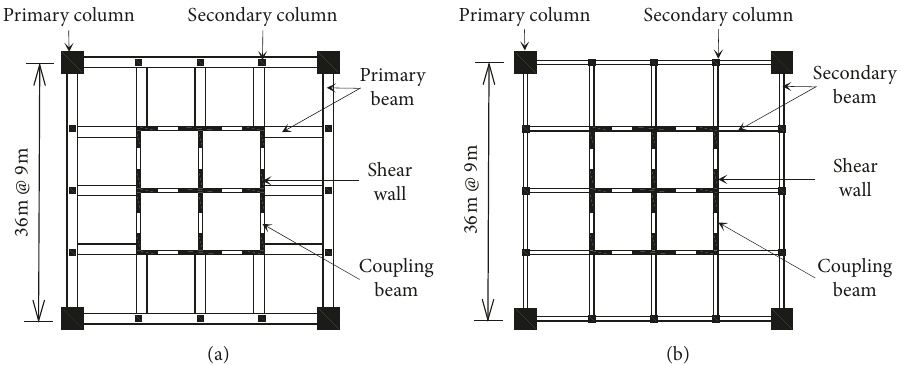
Figure 1: Plan of primary frame- and secondary frame-braced structure analysis models: (a) primary story plan; (b) secondary story plan.